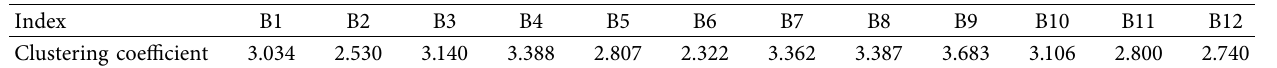
Table 8: Clustering coefficients for each secondary indicator.